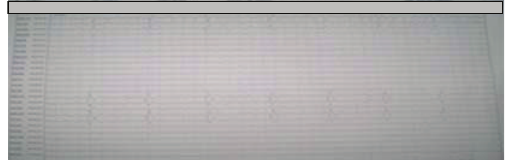
Figure 4: Low-voltage EEG recording with multiple ECG